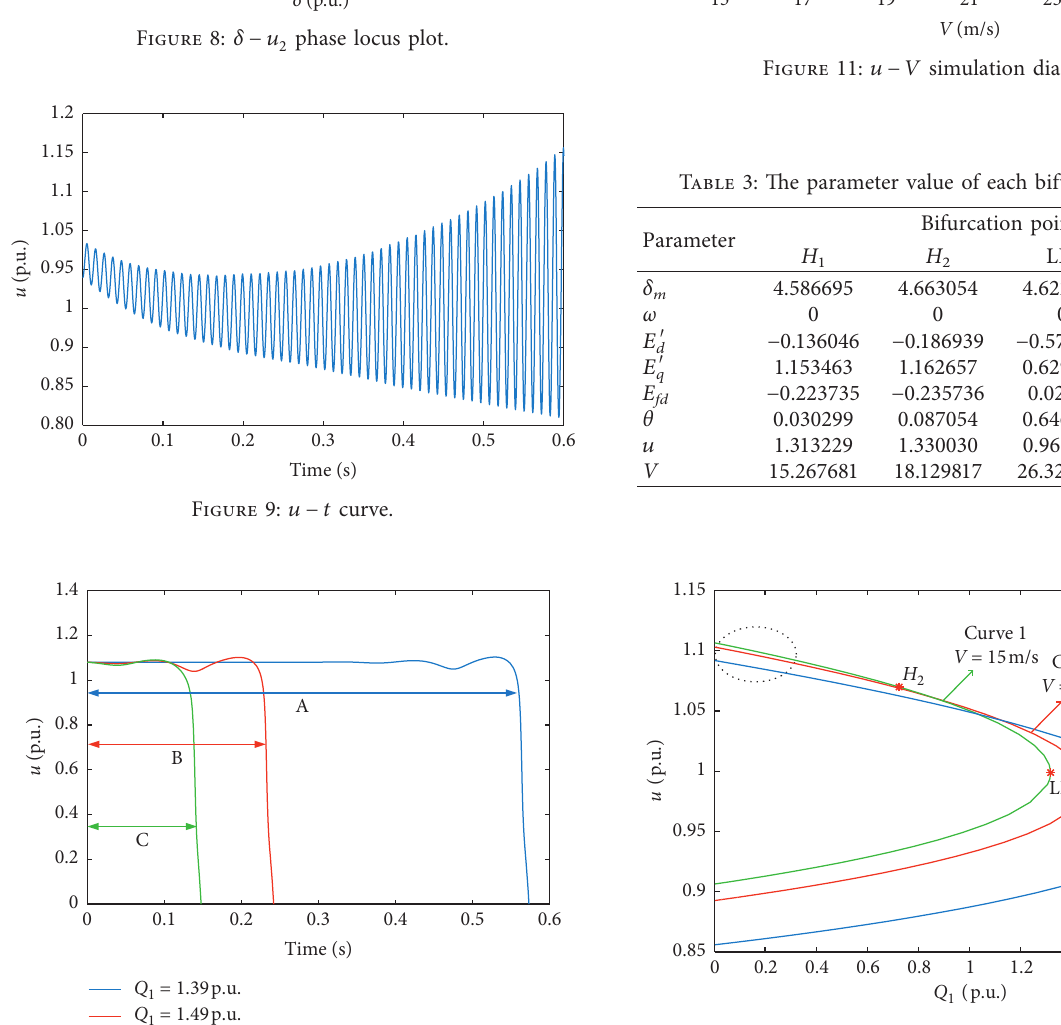
Figure 12: Q − u simulation curve under different wind 1